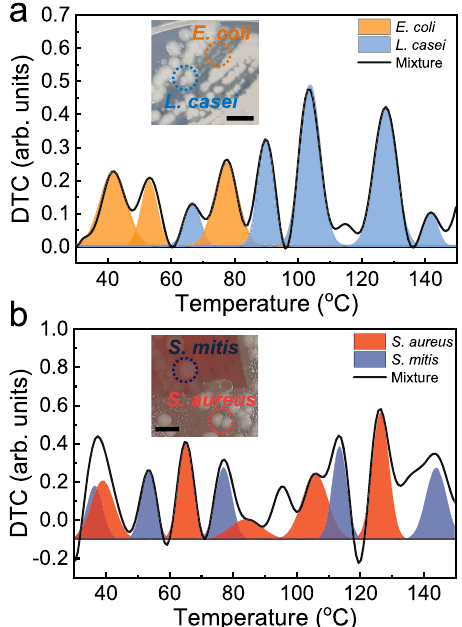
Fig. 5 Thermal curve analysis for a mixture of bacteria. a DTC for a mixture of E. coli and L. casei bacteria. The curve was decomposed by those of E. coli (orange) and L. casei (sky-blue) based on their respective peak positions obtained from Fig. 4. b DTC for a mixture of S. aureus and S. mitis bacteria, which was decomposed by those of S. aureus (red) and S. mitis (blue). Insets in ( a , b ) are the pictures of bacterial layers grown in respective culture media (scale bar: 5